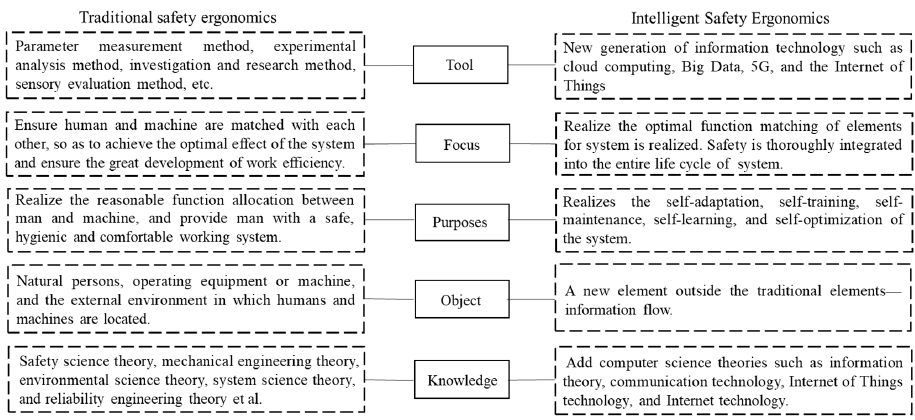
Figure 4. The difference between traditional safety ergonomics and ISE. The differences can be an- alyzed according to the tools, focus, purposes, objects, and